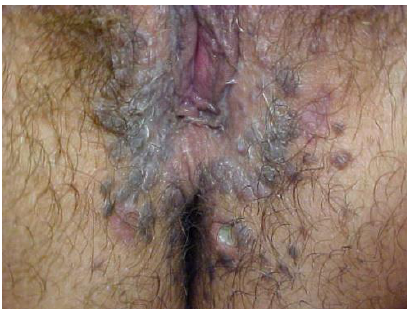
Figure 22. Pigmented HSIL.